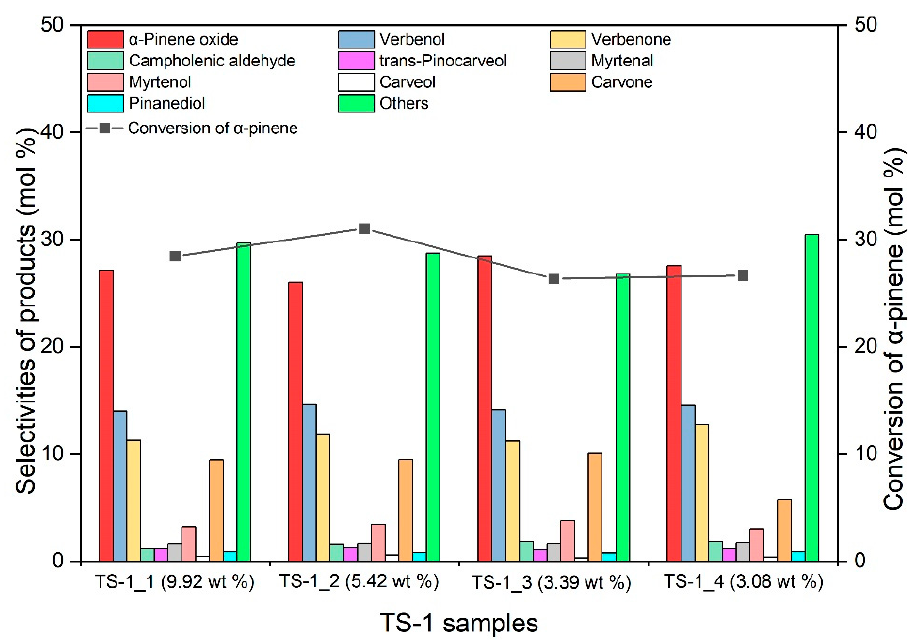
Figure 7. Values of conversion of α -pinene and selectivities of appropriate products in the oxidation of α -pinene over TS-1_1, TS-1_2, TS-1_3 and TS-1_4 catalysts (temperature 85 °C, catalyst content 2.5 wt% and reaction time 6 h). The figure shows the sum of the selectivities of the remaining by-products, which were formed with low selectivities.